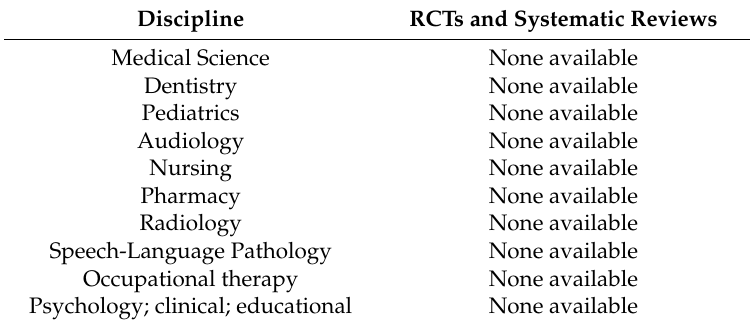
Table 1. Major disciplines involved in public health policy and the evidence base to support them.